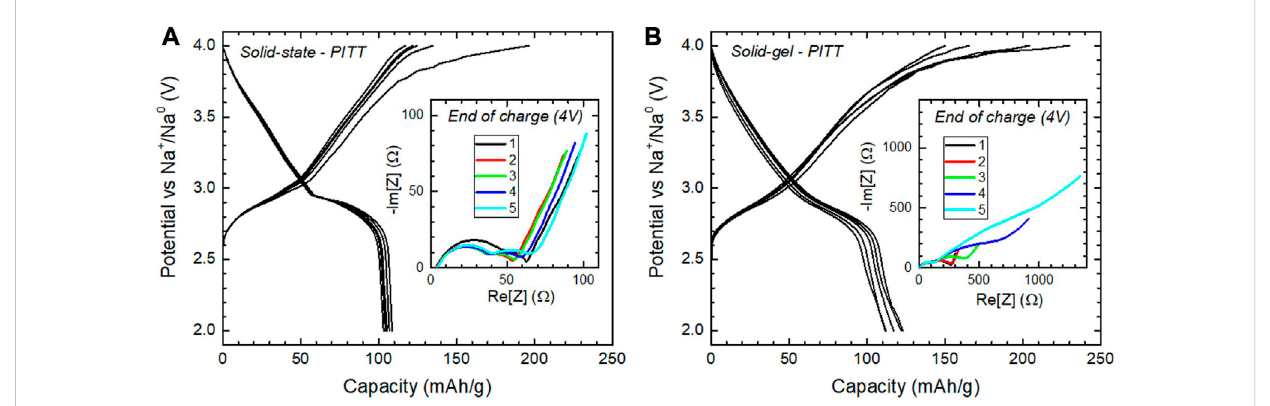
FIGURE 8 Results from the coupled PITT-EIS experiment of (A) O3-NaNMF-SS and (B) O3-NaNMF-SG. Main panels: PITT curve for fi ve cycles. Insets: EIS pattern at the end of each PITT charge (4